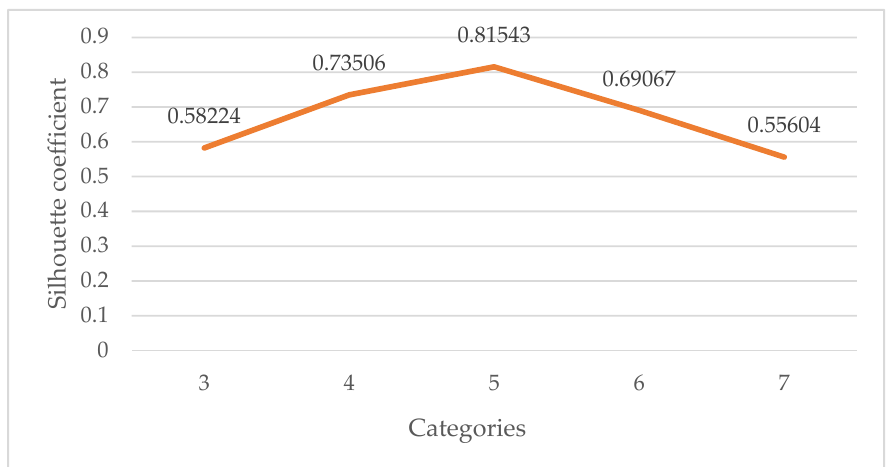
Figure 4. Silhouette coefficients for the clustering categories from 3 to 7.